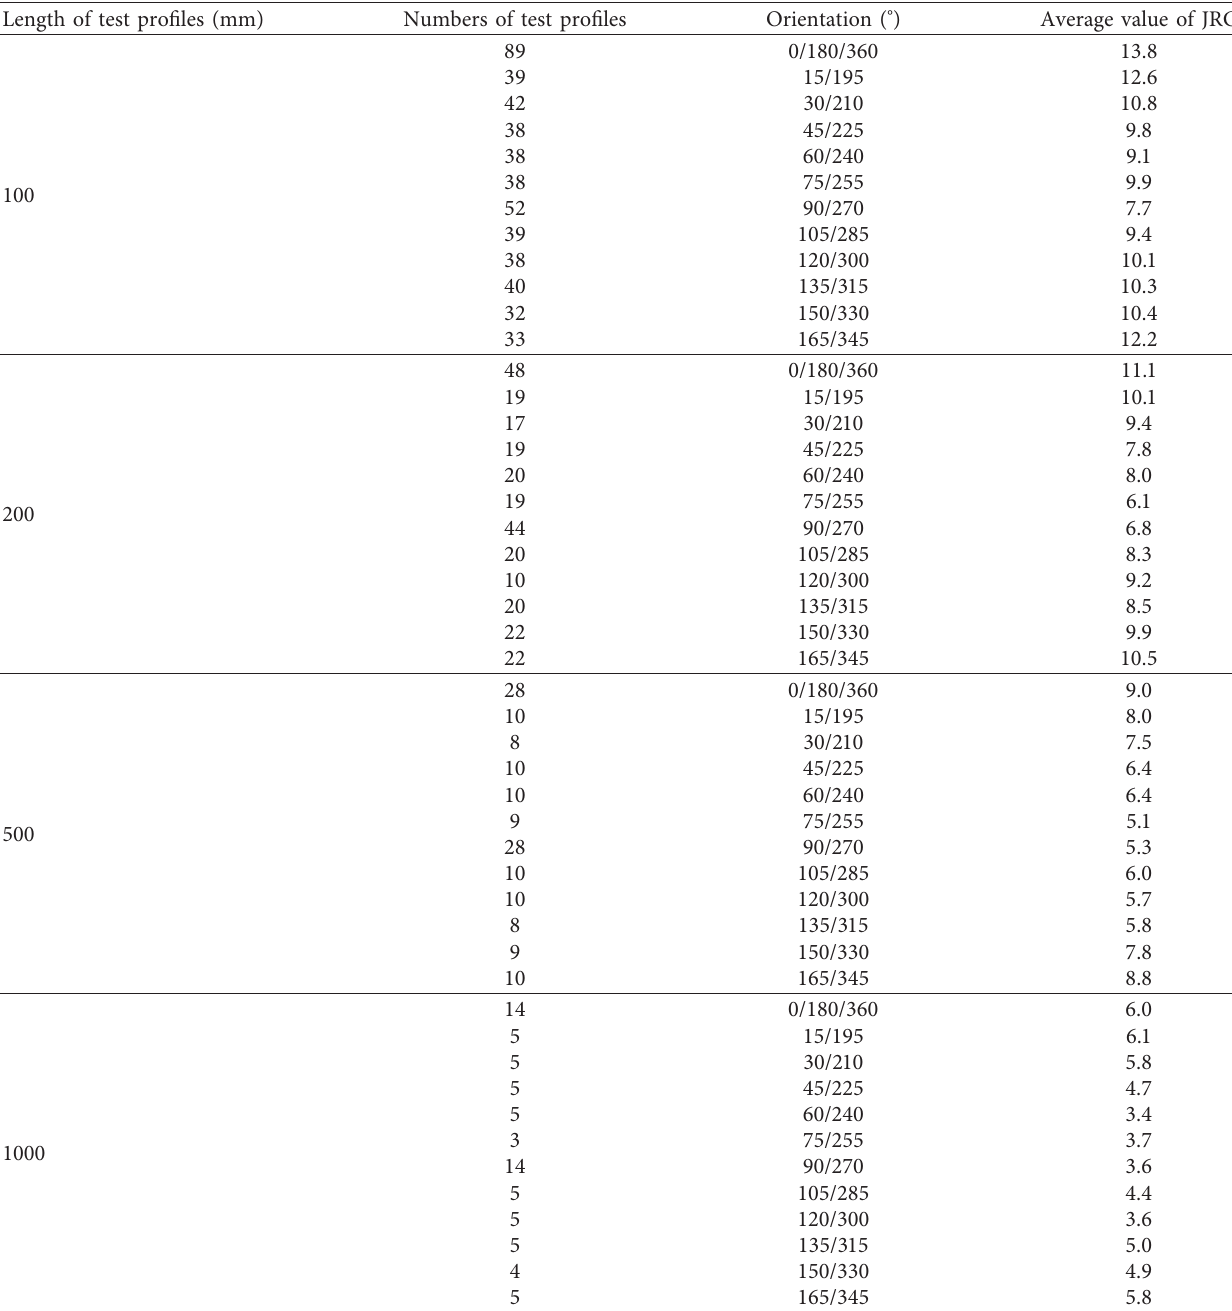
Table 2: Summary of JRC values of test samples obtained in different orientations and their variations with sample scale. Length of test profiles